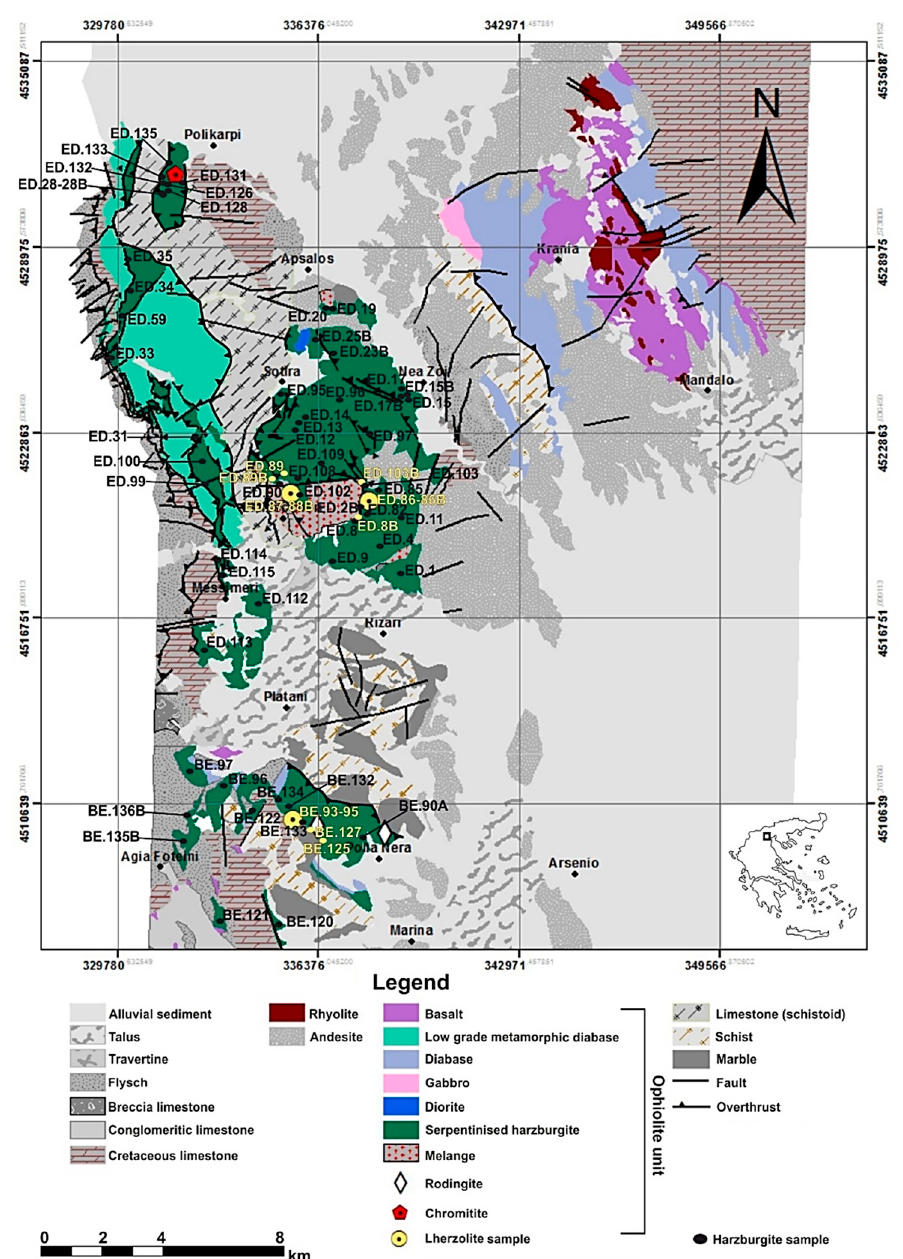
Figure 2. Geological and sampling map of the Edessa ophiolite (from IGME [38,39], modified after fieldwork and mapping by using ArcMap 10.1); rectangle in the inset shows the study area.